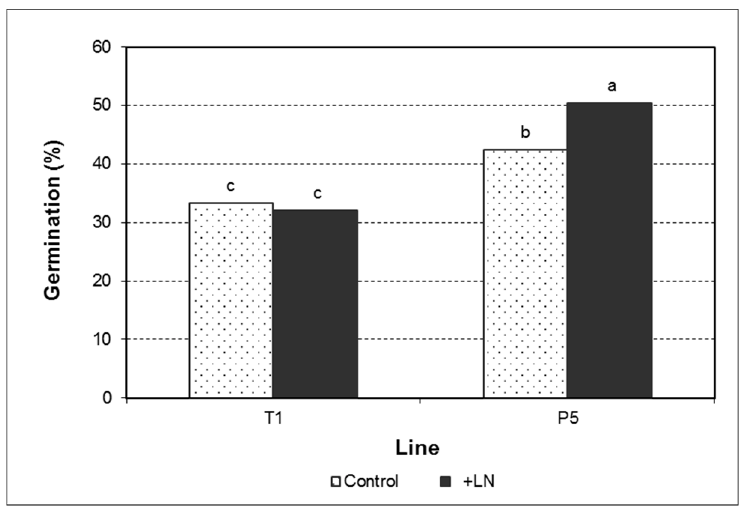
Figure 7. Germination of olive somatic embryos developed from control and cryopreserved embryogenic cultures of the lines T1 and P5. Data assessed after two six-week recultures on germination conditions. Different letters indicate significant differences by the R × C test of independence with a significance level of 0.05.